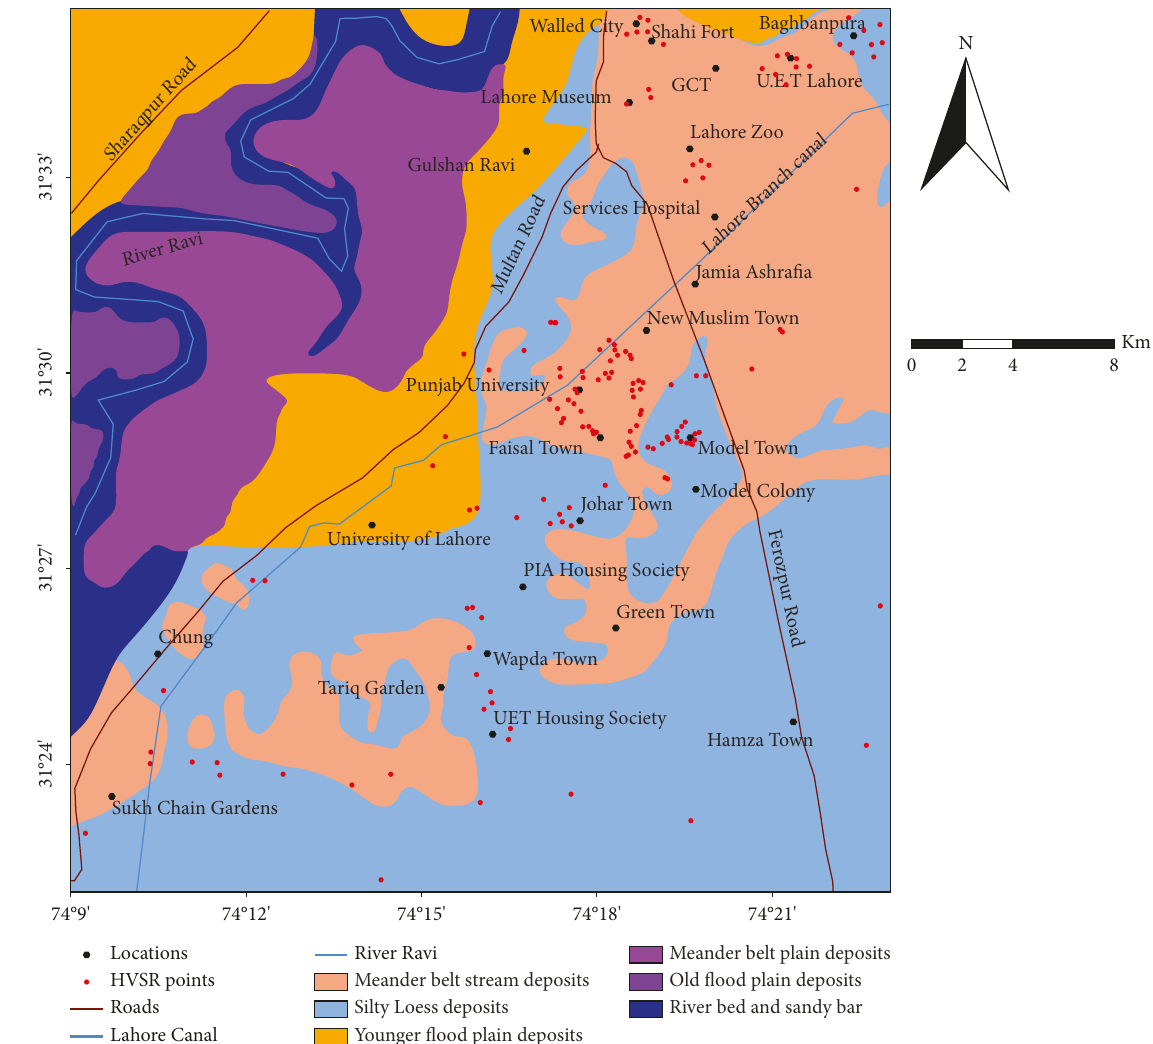
Figure 1: Geological map of the study area and acquired HVSR data points in the